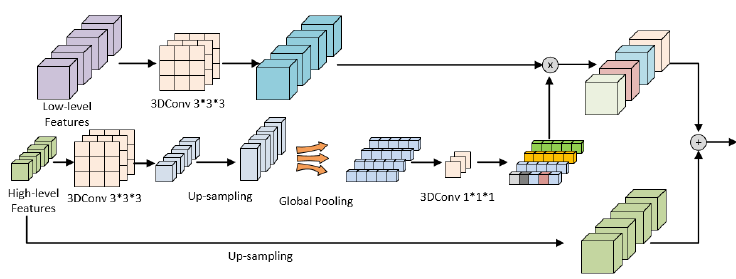
Figure 4. Our proposed 3D Context-guided Attention module